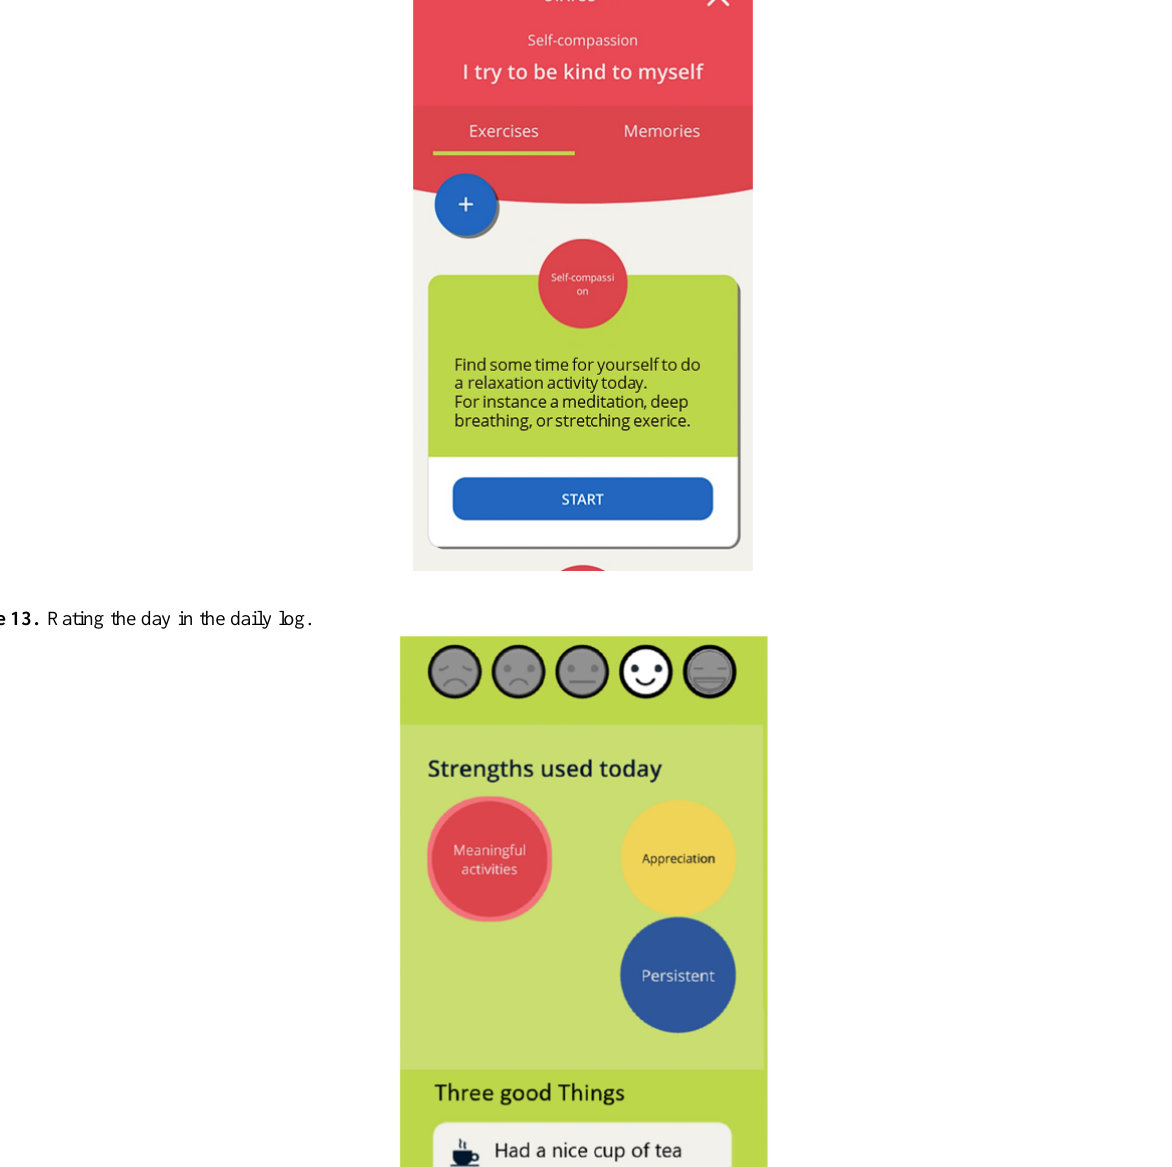
Figure 12. Strengths Exercise.